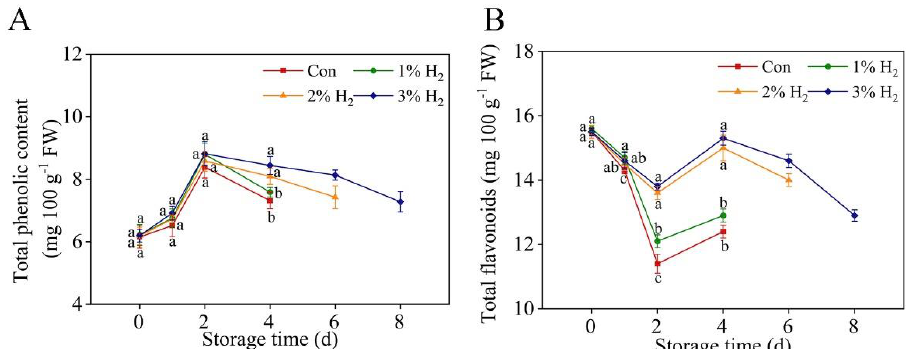
Figure 2. Time-dependent changes of total phenolic ( A ) and flavonoid ( B ) contents in response to molecular hydrogen. Chinese chive was stored at 4 ± 1 °C. Meanwhile, related parameters were analyzed. Means ± SE ( n = 3 for phenolic and flavonoid contents, respectively) followed by different letters for each storage time indicate a statistical difference at p < 0.05.